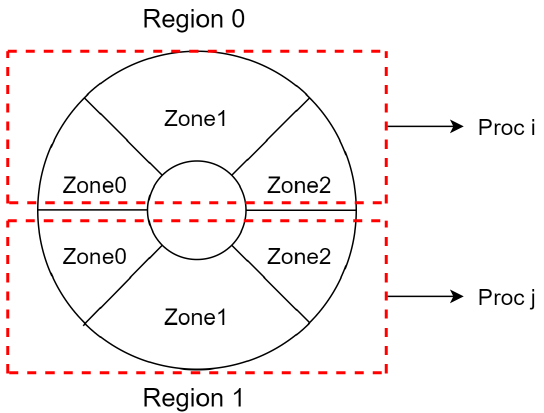
Figure 4. Partition level of two